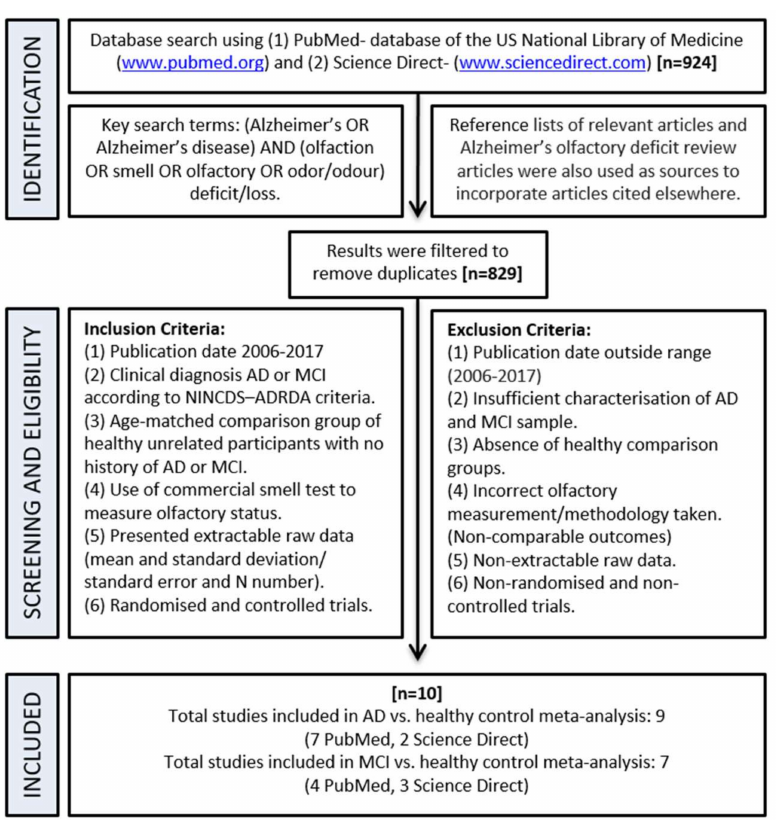
Figure 4. A flow chart showing the process of identifying suitable studies for the